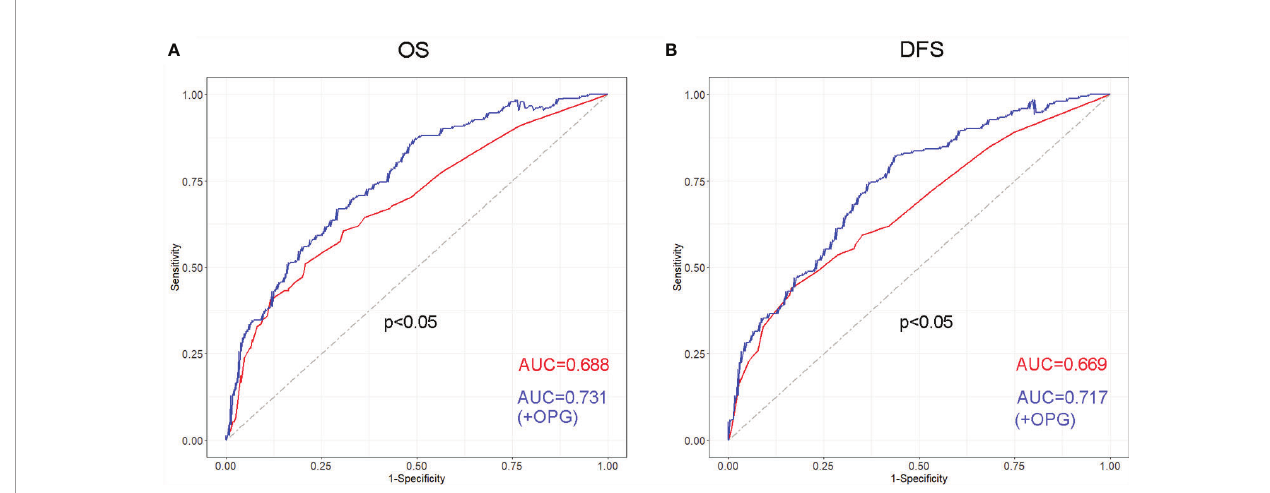
FIGURE 5 | Receiver operating characteristic (ROC) curve and its corresponding AUCs for the models with or without OPG in terms of OS (A) and DFS (B) .